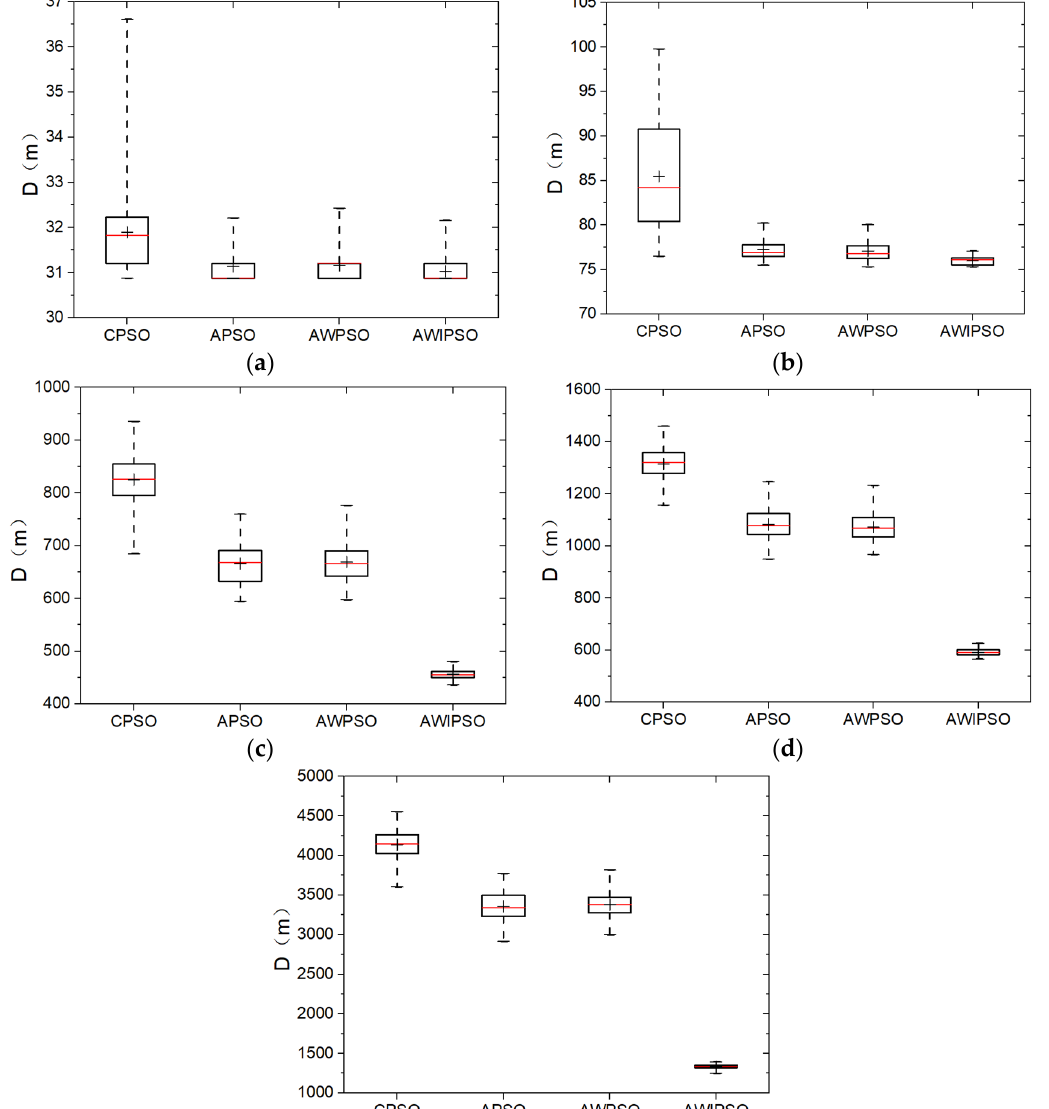
Figure 2. Solution distribution of each algorithm with five numbers of planned points: ( a ) Q = 14; ( b ) Q = 22; ( c ) Q = 51; ( d ) Q = 76; ( e ) Q = 99.